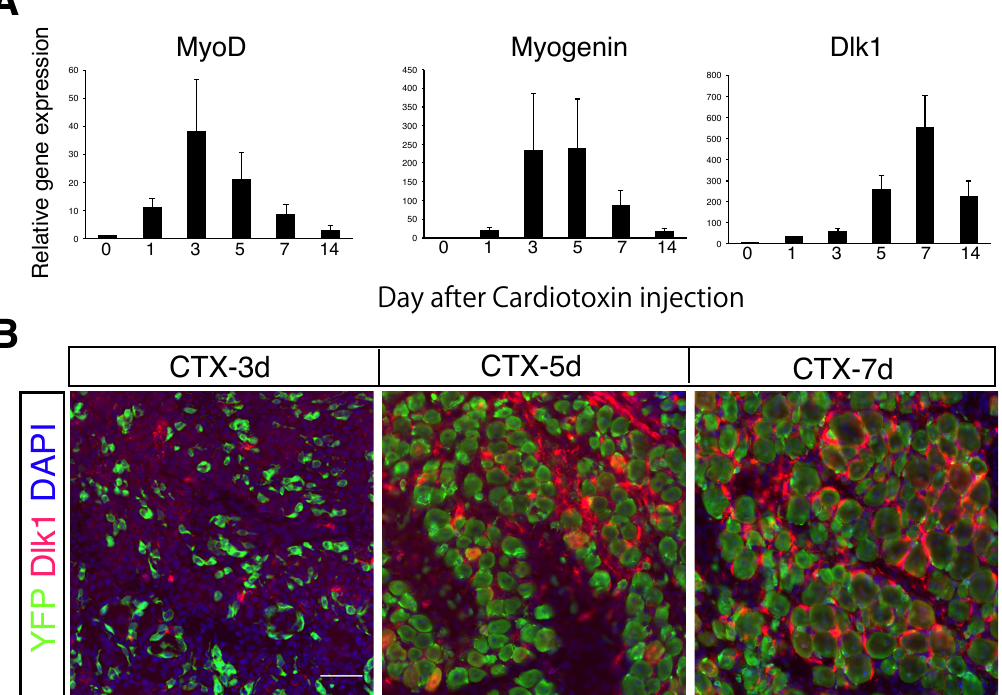
Figure 2. Dlk1 expression during muscle regeneration. ( A ) Relative expression level of MyoD, myogenin, or Dlk1 in intact and regenerating TA muscles. Data show the average of five independent experiments with the SD. ( B ) Immunostaining of Dlk1 (red), myogenic cells (green), and DAPI in regenerating muscle of Pax7 CreERT2 /+ ::Rosa-YFP mice treated tamoxifen on the indicated days after CTX injection. Scale bar: 50 µ